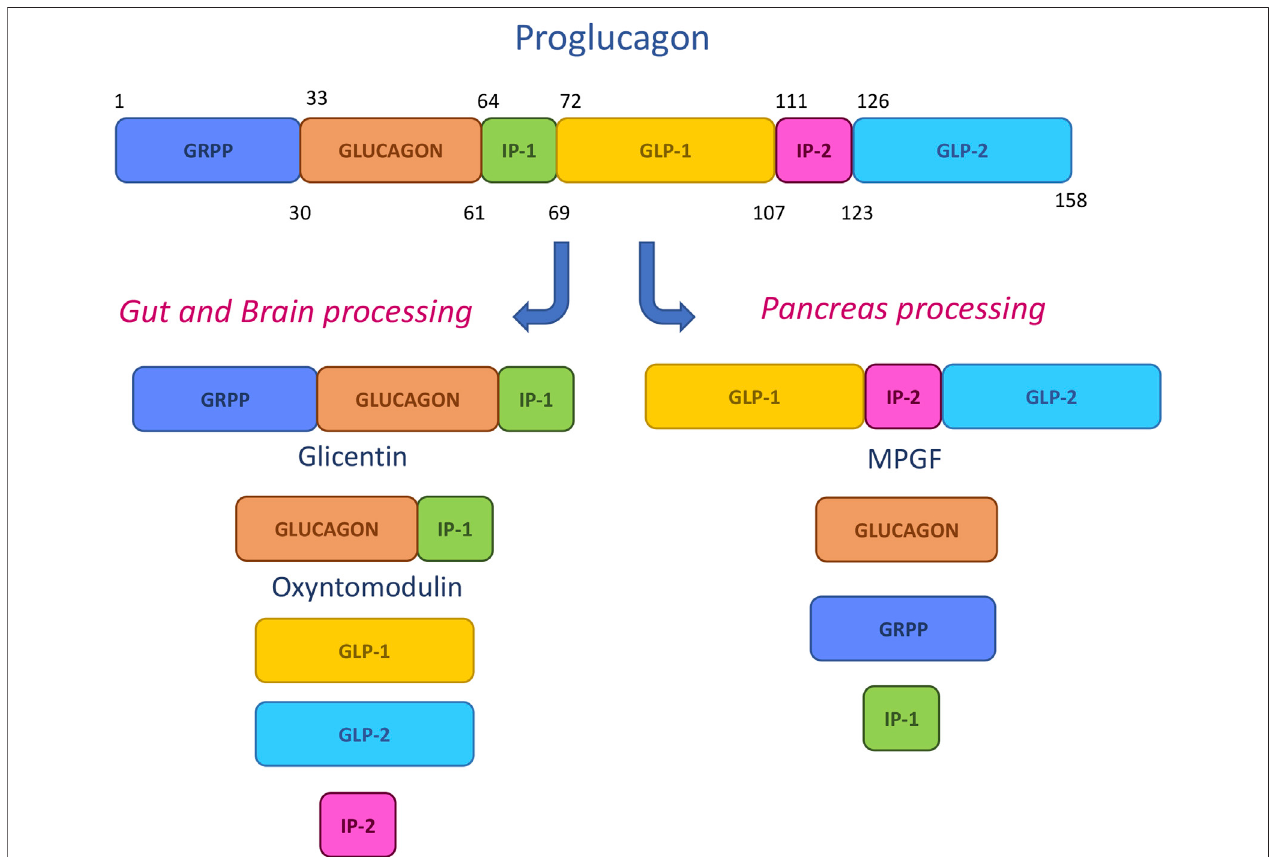
FIGURE 5 | Tissue-speci fi c proglucagon